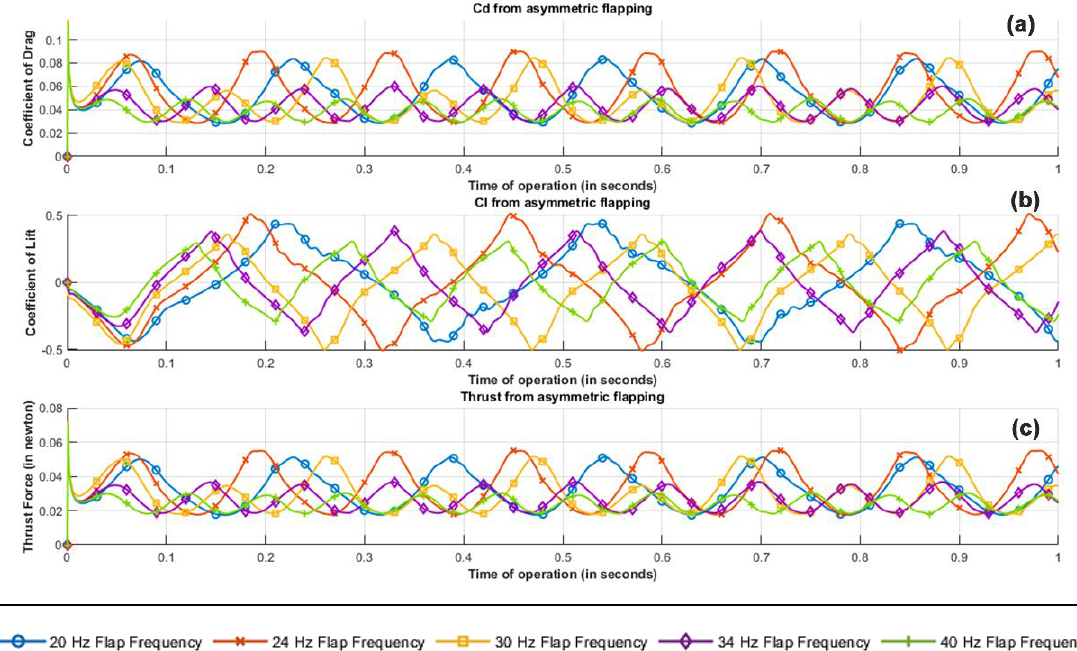
Figure 21. Averaged flow field metrics of left and right asymmetric flapping plate configurations; ( a ) coefficient of drag, ( b ) coefficient of lift, ( c ) thrust force along the positive x axis.